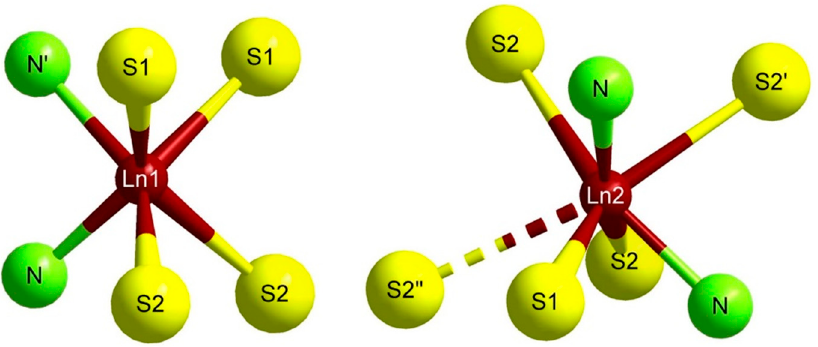
Figure 1. Coordination polyhedra around ( Ln 1) 3+ and ( Ln 2) 3+ in the A-type crystal structure of the Ln 4 N 2 S 3 series ( Ln = Ce–Nd).